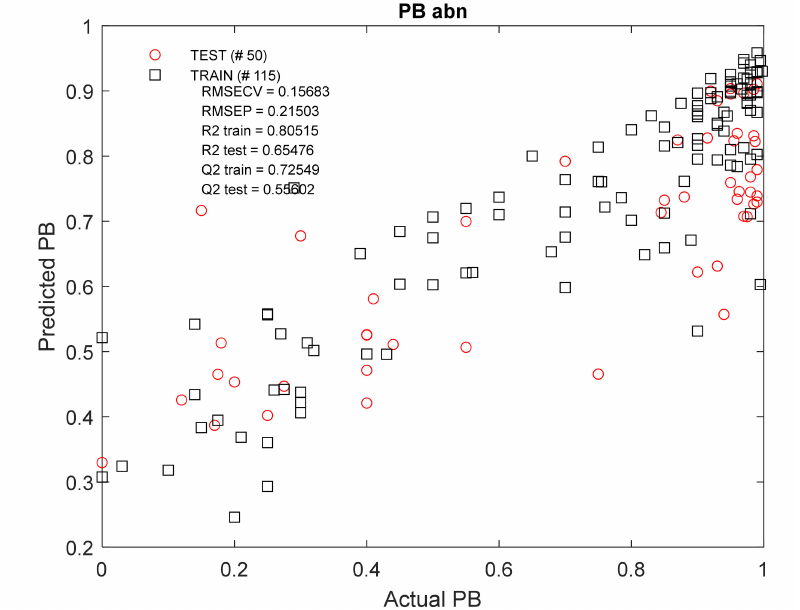
Figure 6. Actual versus predicted PB abn values using RF regression modelling of molecular descriptor set containing 23 variables. RMSE CV = root-mean-square error of cross-validation, RMSE P = root- mean-square error of prediction, R 2 train/test = coefficient of determination for train/test set models, Q 2 train/test = coefficient of determination for the cross-validated models.